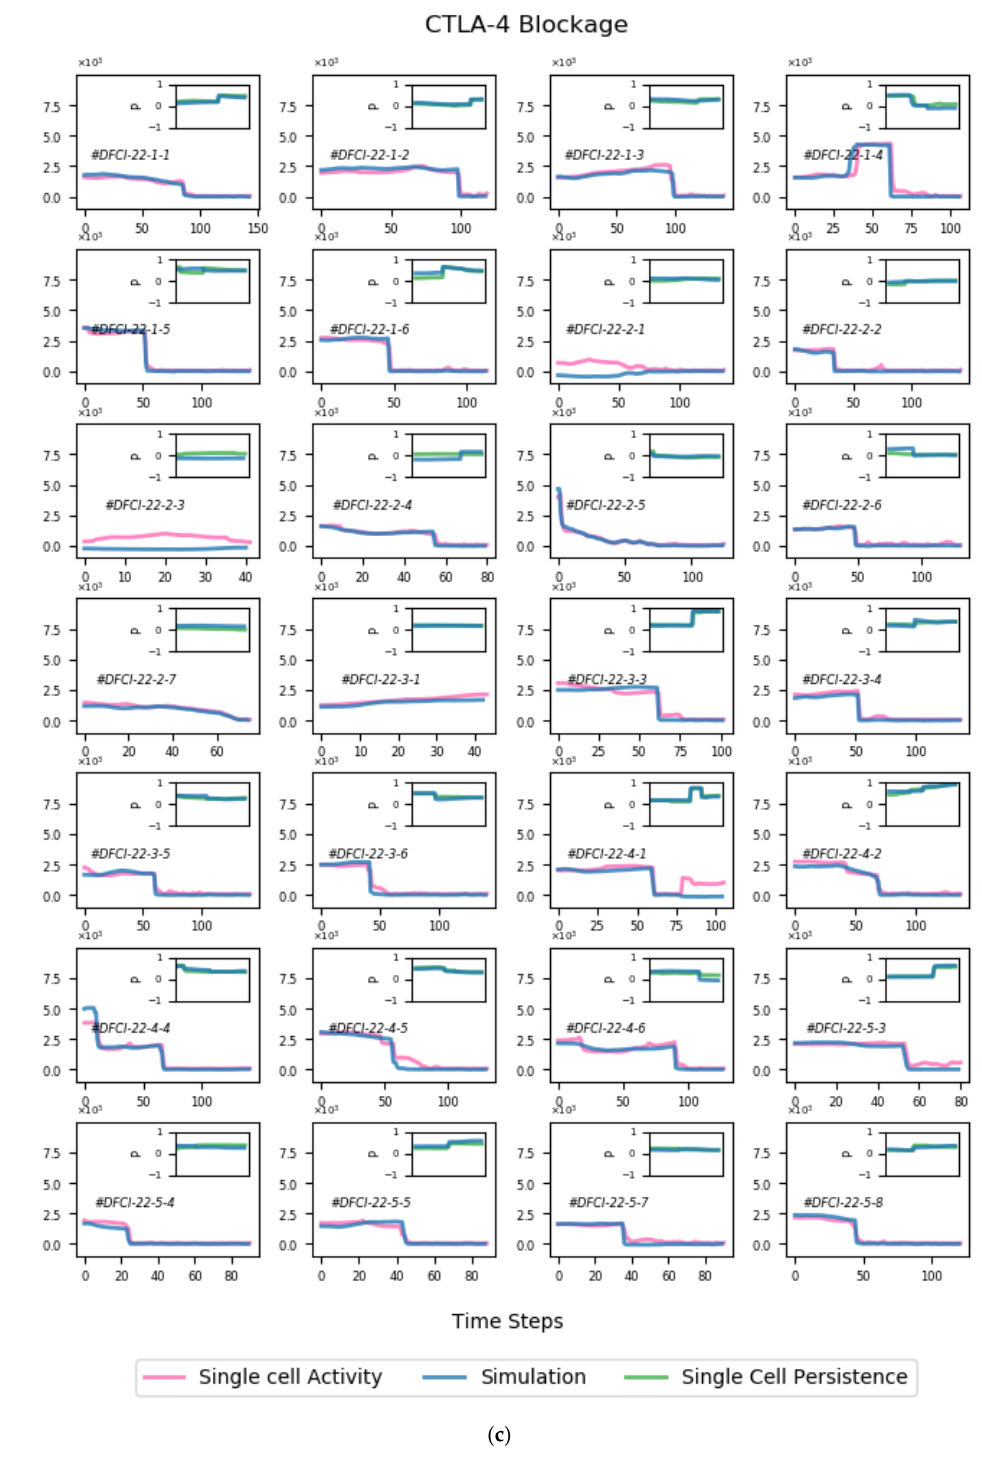
Figure A2. Single-cell parameters of AR-1 model of migration in combined inhibition of PD-1 and CTLA-4 pathways (a) as well as PD-1 (b) and CTLA-4 blockade (c). The Bayesian inference method was applied to time series of cell trajectories, and the mean values of the inferred activity parameter are shown for each cell (pink curves). The results of parameter estimation for AR1- simulated trajectories (blue curves) show good agreement with those derived from the experiment. Insets: Single-cell persistence of the cells (dark green curves) and simulation-derived ones (light green curves). The # notes indicate IDs of patients from Dana–Farber Cancer Institute, the number of tumor spheroids, and the tracked cell number, in that